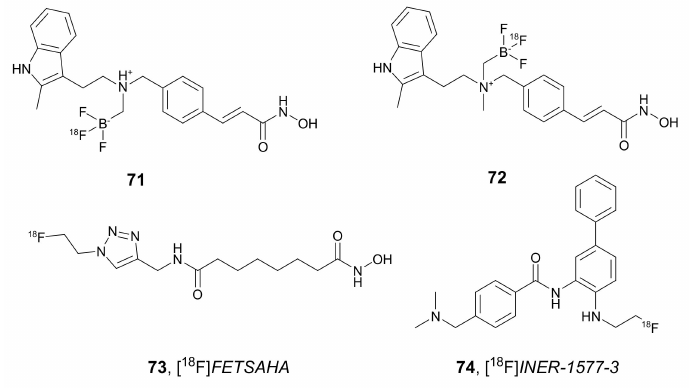
Figure 25. Chemical structures of compounds 71 – 74 .